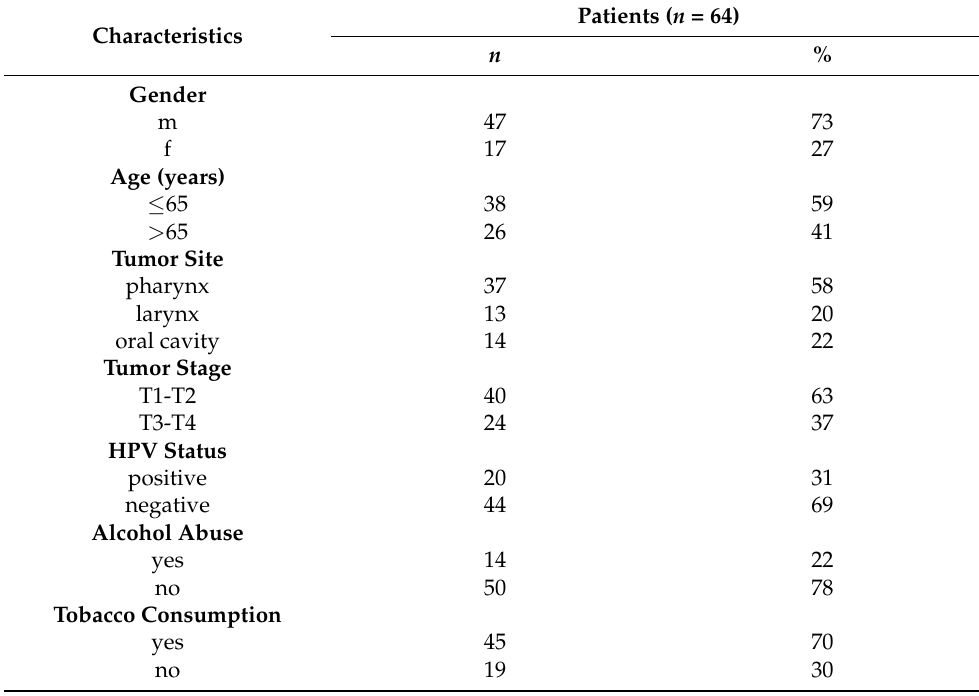
Table 1. Clinicopathological